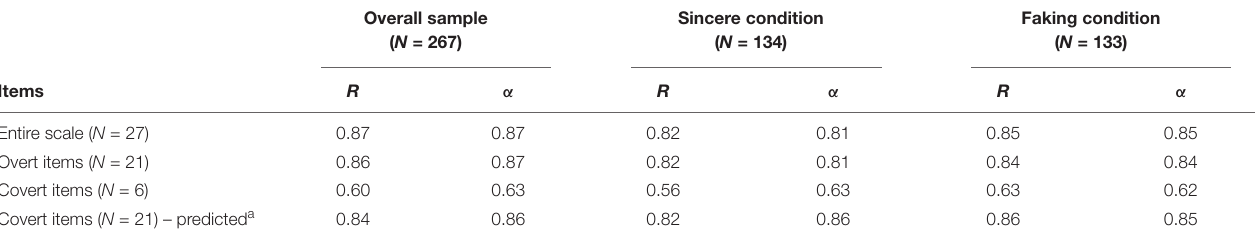
TABLE 2 | Internal consistency of the Roman Alexithymic Scale.